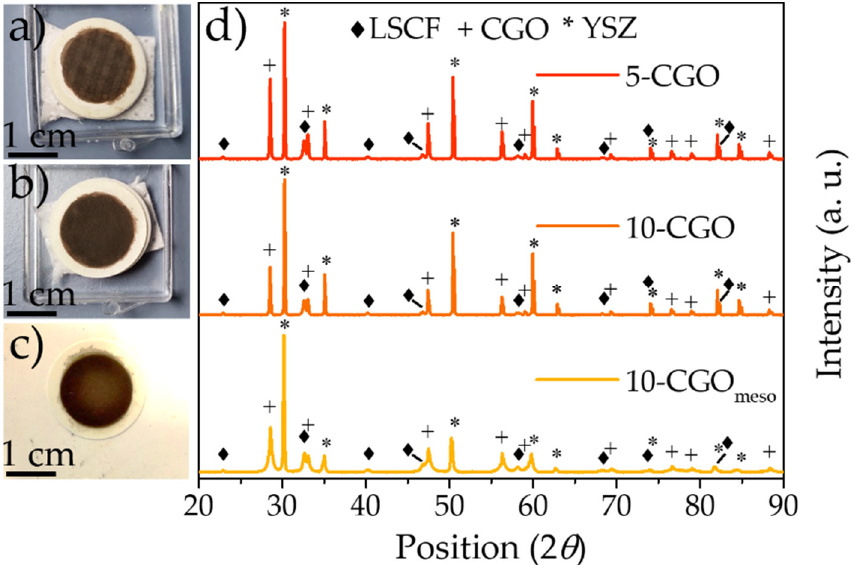
Figure 2. Digital pictures of the 5-CGO ( a ), 10-CGO ( b ) and 10-CGO meso ( c ) cells. XRD of the 5-CGO,10-CGO and 10-CGO meso cells after the infiltration and calcination of the LSCF solution ( d ). The presence of the LSCF characteristic peaks confirms the formation of the perovskite after the calcination process.